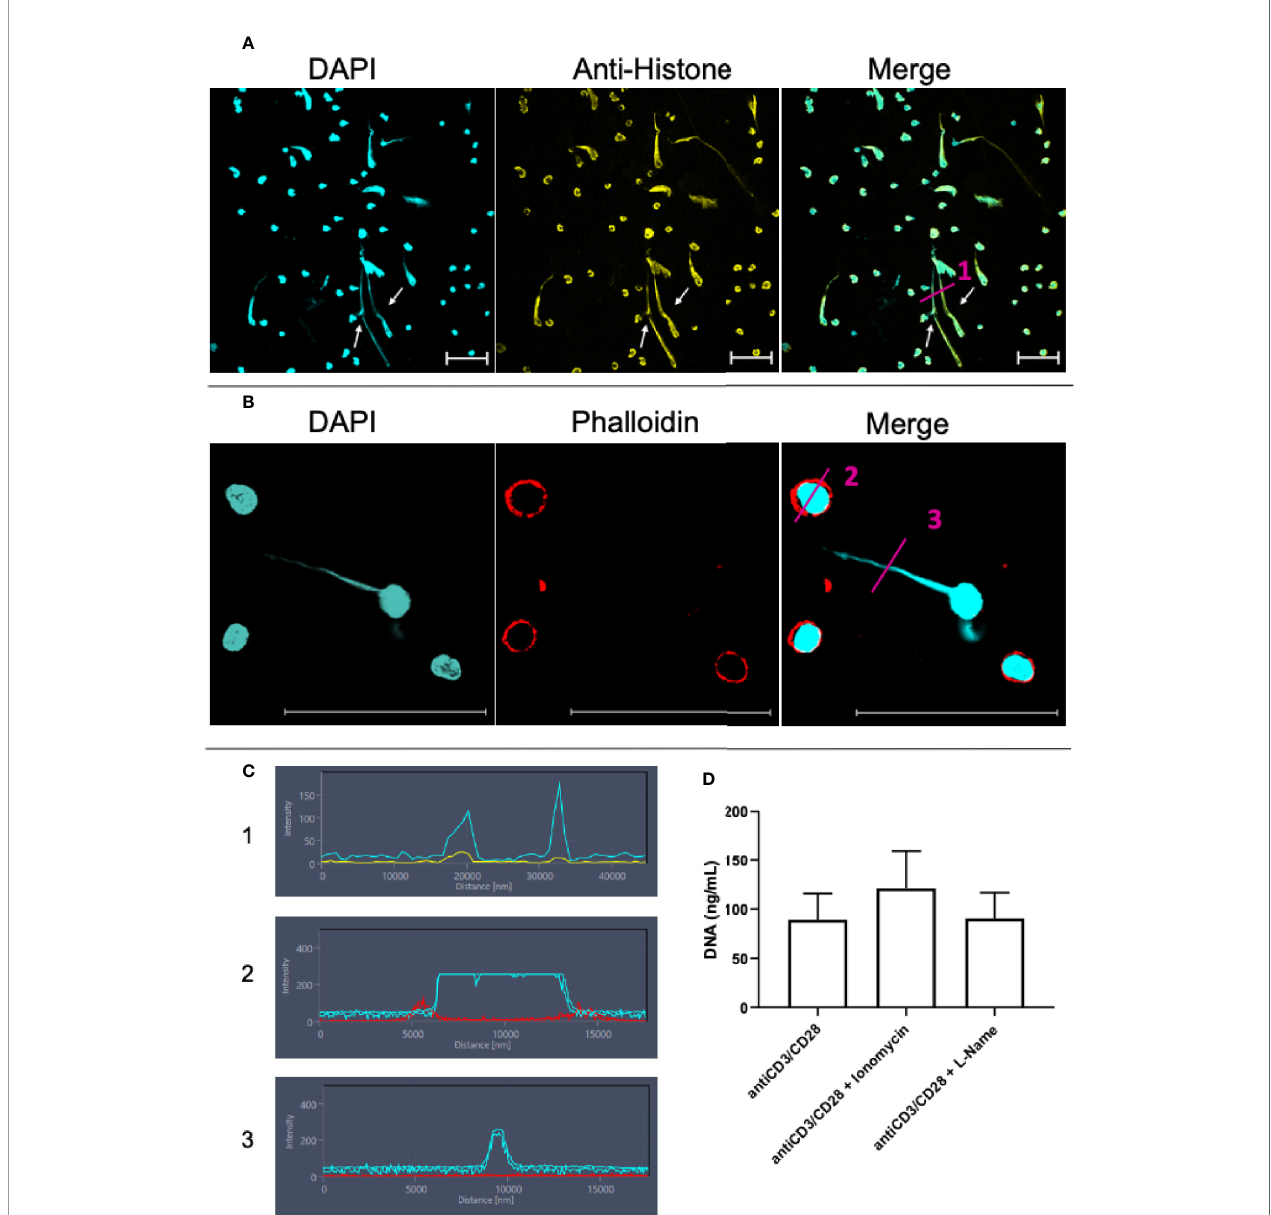
FIGURE 3 | Lymphocytes are able to release extracellular traps (ETs) composed of DNA and histones. T lymphocyte-enriched preparations were plated on poly-L- lysine coverslips, stimulated or not with anti-CD3/anti-CD28 and maintained in culture for 24 h. The preparations were stained with DAPI (light blue) and/or anti- histone (yellow), and/or phalloidin (red - actin evidence). Bars = 50 µm. (A) Representative confocal image of culture stimulated with anti-CD3/anti-CD28 and labeled with DAPI (light blue)/anti-histone (yellow). Arrows highlighted extracellular traps observed in the stimulated cultures. (B) Samples were stained with DAPI (light blue)/ phalloidin (red). (C) shows histograms derived from the details marked with (1), (2) and (3) in panels (A, B) , showing the co-localization of DAPI and histones (1) and the lack of co-localization of DAPI and actin in the cell body (2) and in the extracellular DNA-structure (3). (D) shows the effect of ionomycin and L-NAME in the release of extracellular DNA by anti-CD3/anti-CD28 stimulated